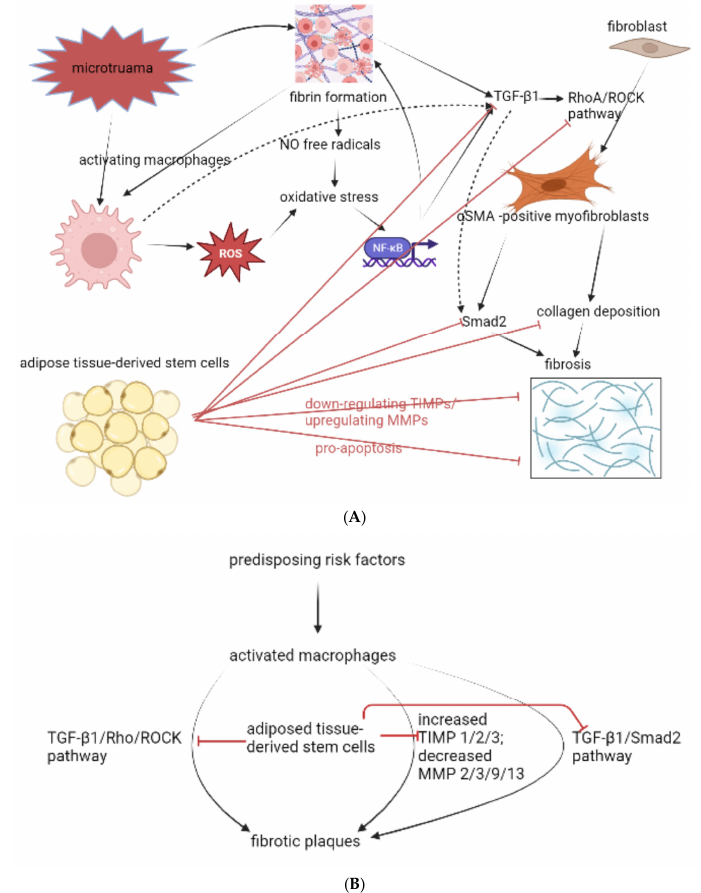
Figure 3. ( A ) The current preclinical studies of applying ADSCs in treating PD. In published litera- ture, only the downstream pathways were discussed. Several pivotal impacts by ADSCs were not yet addressed, such as macrophages polarization, free radicals, oxidative stress, and NF- κ B. ( B ) The abbreviated illustration of how ADSCs alter the immunological microenvironment of PD. In